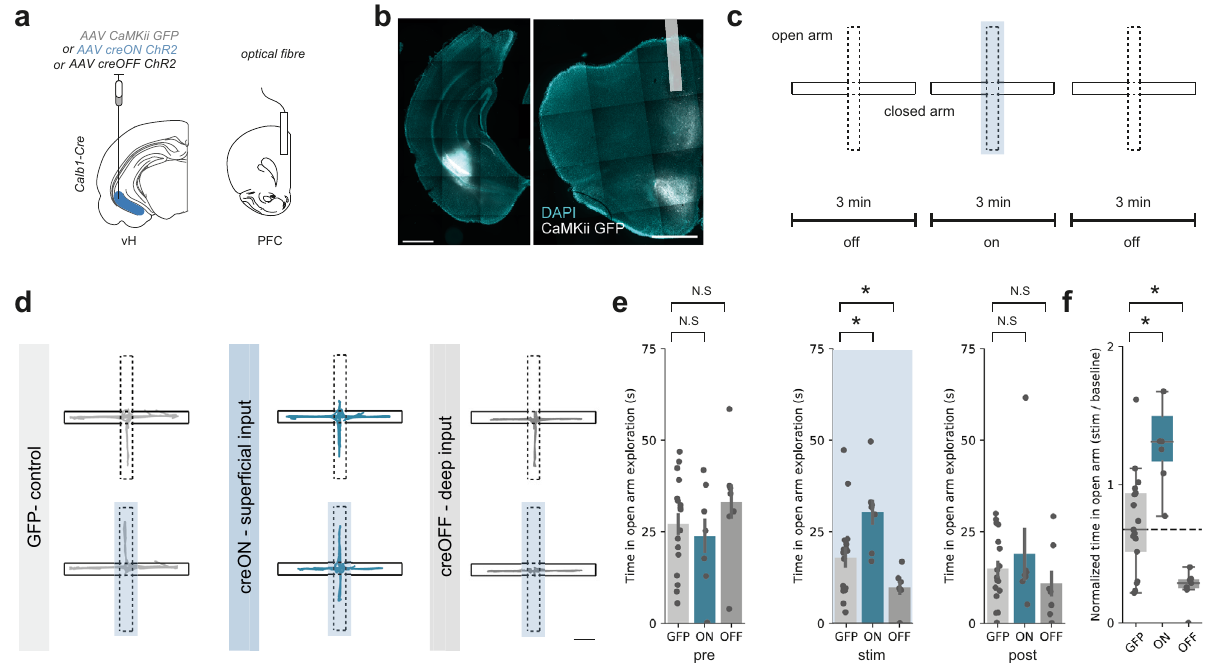
Fig. 6 Super fi cial and deep vH-PFC populations bidirectionally in fl uence behaviour in the EPM. a Strategy for in vivo optogenetic manipulation of vH axons from each layer in PFC. b Example images of viral injection into vH (left) and optic fi bre implant in PFC (right). Scale bars = 1000 µ m. Image representative of slices from all mice used in optogenetic experiments below. c Schematic showing experimental design. d Trajectories of an example mouse during baseline (top) and during stimulation (bottom) for GFP (left), creON (centre) and creOFF (right) experiments. Scale bar = 10 cm. e Summary showing time spent in open arm exploration during the fi rst 3 min epoch of no stimulation (left), the central 3 min with light stimulation (blue box, middle) and the fi nal epoch of no light stimulation (right). Note that differences in time spent in open arm exploration are only evident during the central epoch coupled with light stimulation (Mixed ANOVA, interaction between epoch and group: F (4,56) = 4.78, p = 0.002; planned two-sided Welch ’ s paired t test: Pre: GFP vs creON, t (10) = 0.5, N.S. p = 0.61; GFP vs creOFF, t (9.3) = 0.4, N.S. p = 0.39; Stim: GFP vs creON, t (11.9) = 2.5, * p = 0.03; GFP vs creOFF, t (21.7) = 2.4, * p = 0.04; Post: GFP vs creON, t (7.3) = 0.5, N.S. p = 0.61; GFP vs creOFF, t (10.2) = 0.9, N.S. p = 0.40, n = 17 (GFP), 7 (creON), 7 (creOFF) mice). See supplementary statistics table for further information. f Summary of the effect of light-evoked activation on open arm exploration. Super fi cial layer (creON) stimulation increased, while deep layer (creOFF) decreased exploration relative to controls (GFP) (two-sided Mann Whitney, GFP vs creON: U = 12, * p = 0.002; GFP vs creOFF: U = 100, * p = 0.008, n = 17 (GFP), 7 (creON), 7 (creOFF) mice). Dotted line shows median exploration of GFP controls for comparison. Box plots show median, 75th (box) and 95th (whiskers) percentile. Bar charts show mean (bar) and SEM